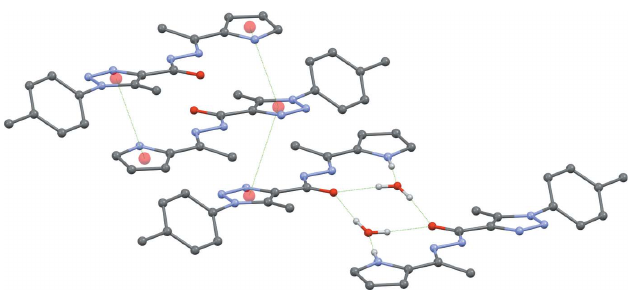
Figure 2 A segment of the crystal structure, showing N—H (cid:2)(cid:2)(cid:2) O and O—H (cid:2)(cid:2)(cid:2) O hydrogen bonds and centroid–centroid contacts as dashed lines. Some H atoms have been omitted for clarity.